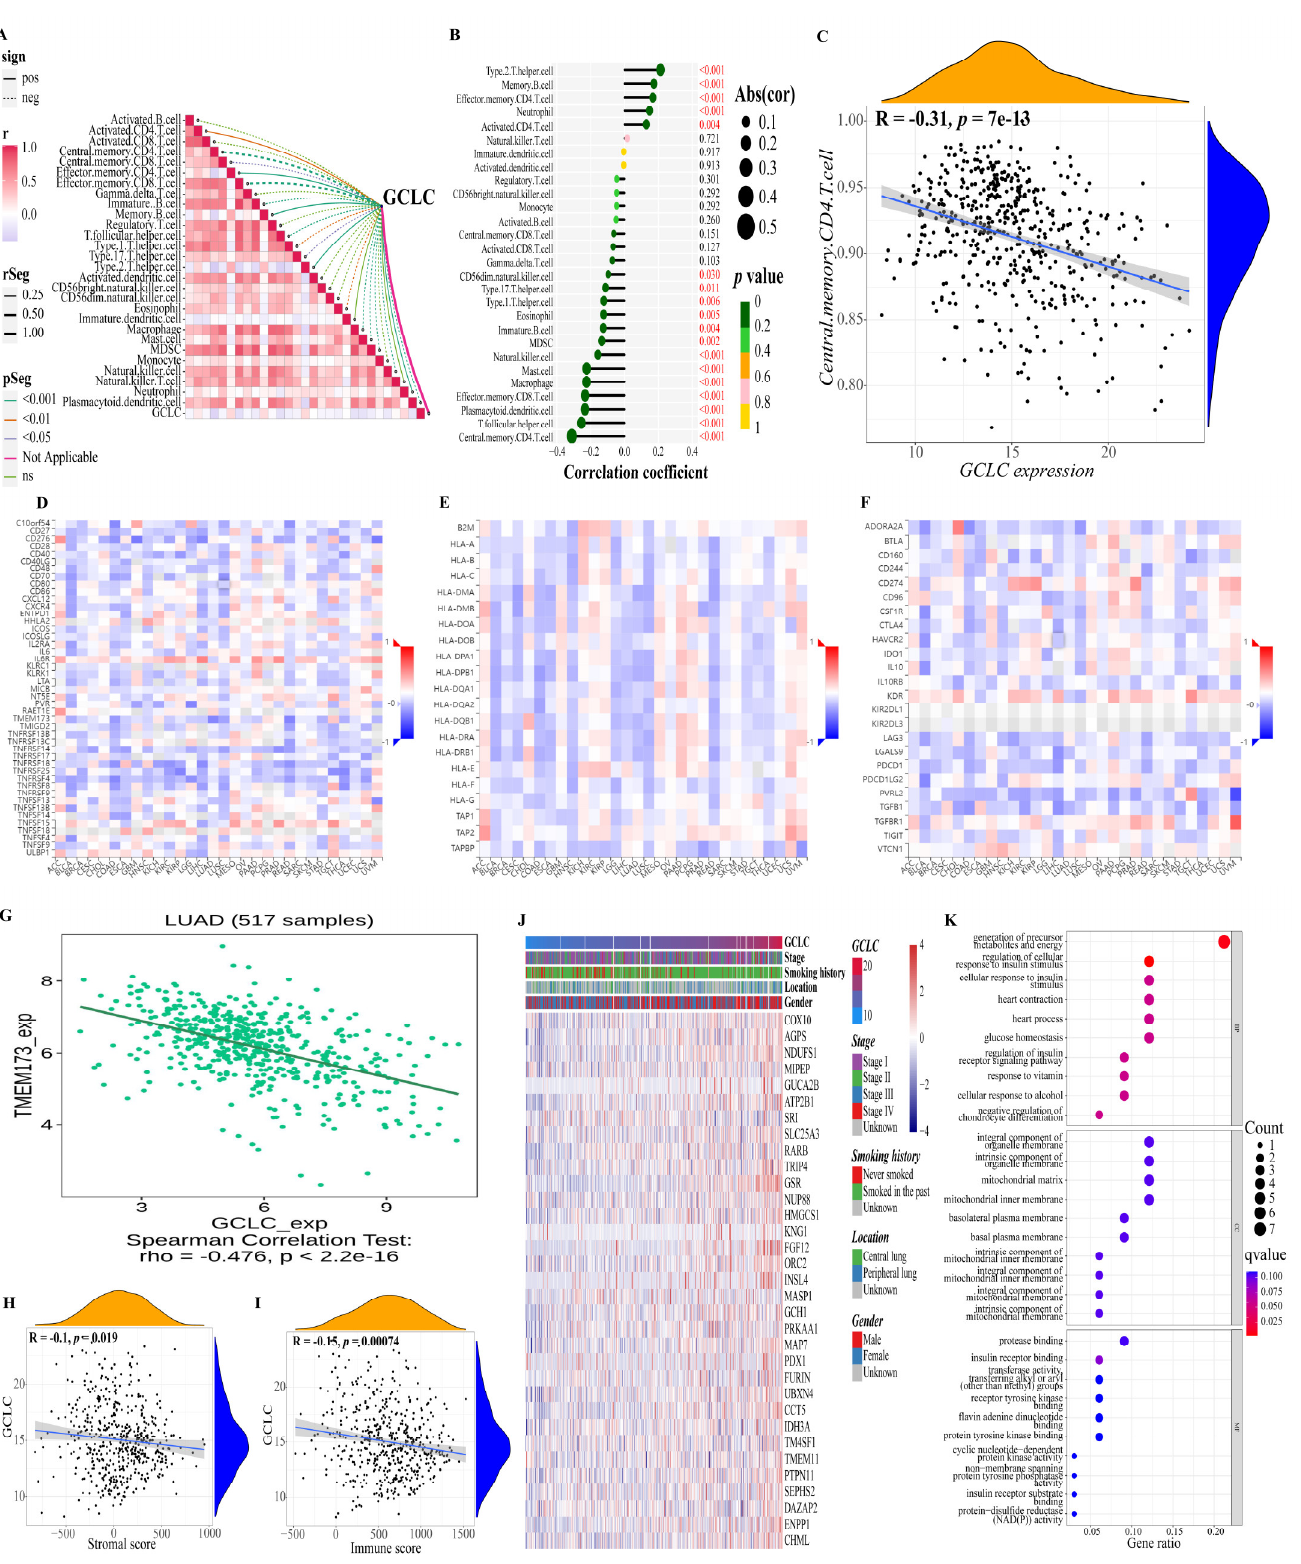
Figure 8. Further study of GCLC in immunity and gene correlation. ( A , B ) Correlations between GCLC and 28 kinds of immune cells (( A ): heat map; ( B ): lollipop graph). ( C ) There is a decent correlation coefficient between central memory CD4 T cell and the expression level of GCLC. ( D – F ) The heat map shows the relations between three kinds of immunomodulators (( D ), Immunostimulator; ( E ), MHC molecule; ( F ), Immunoinhibitor) and the expression of GCLC in Pan-cancer. ( G )